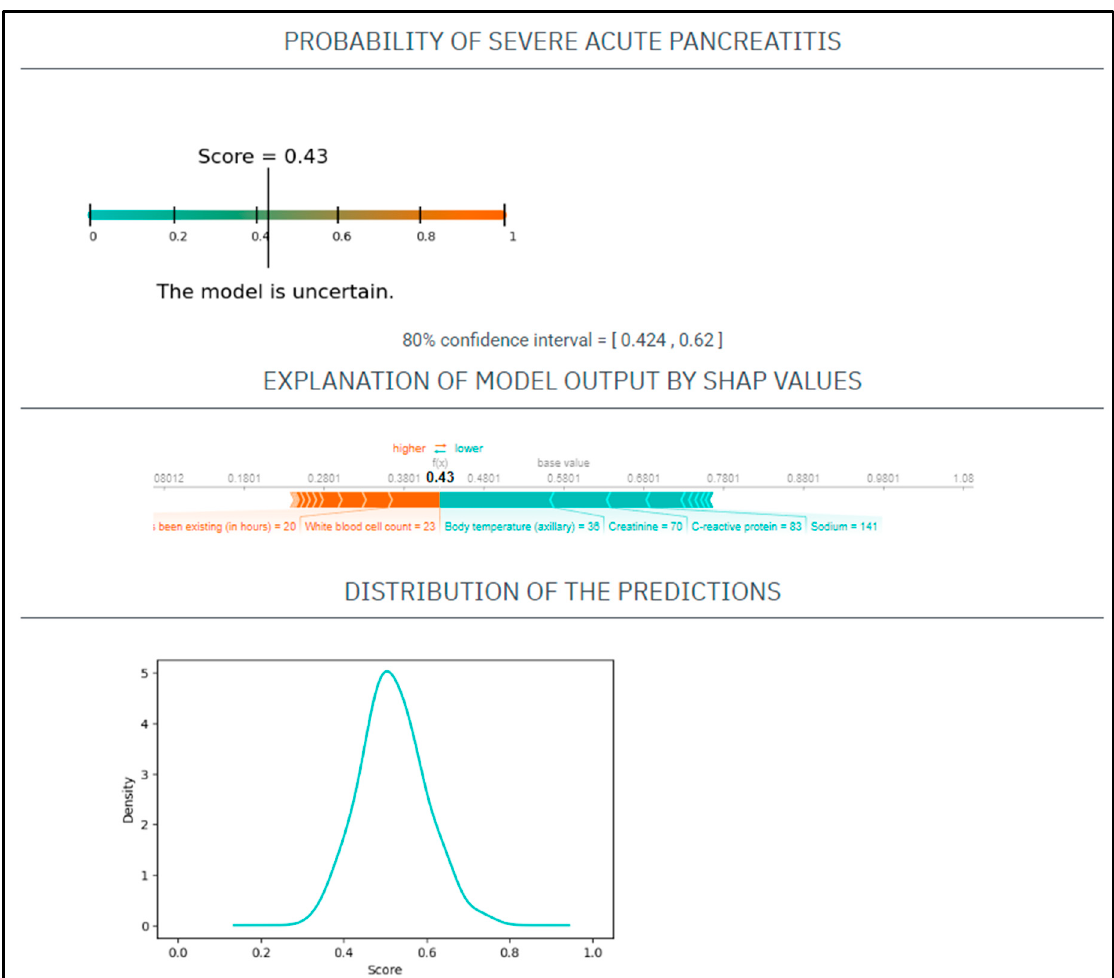
Figure 2. The EASY-APP-s prediction model for the patient in case number